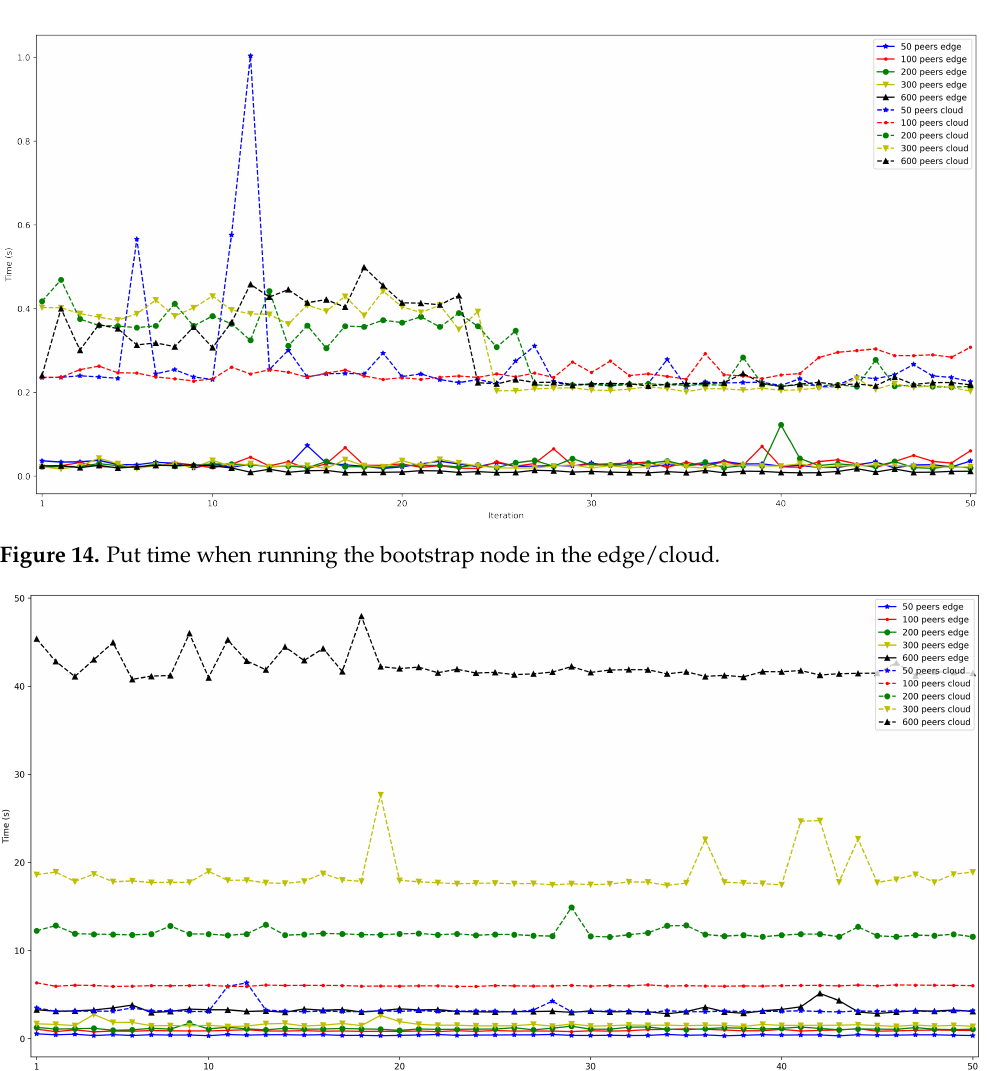
Figure 15. Peer connection time when running the bootstrap node in the